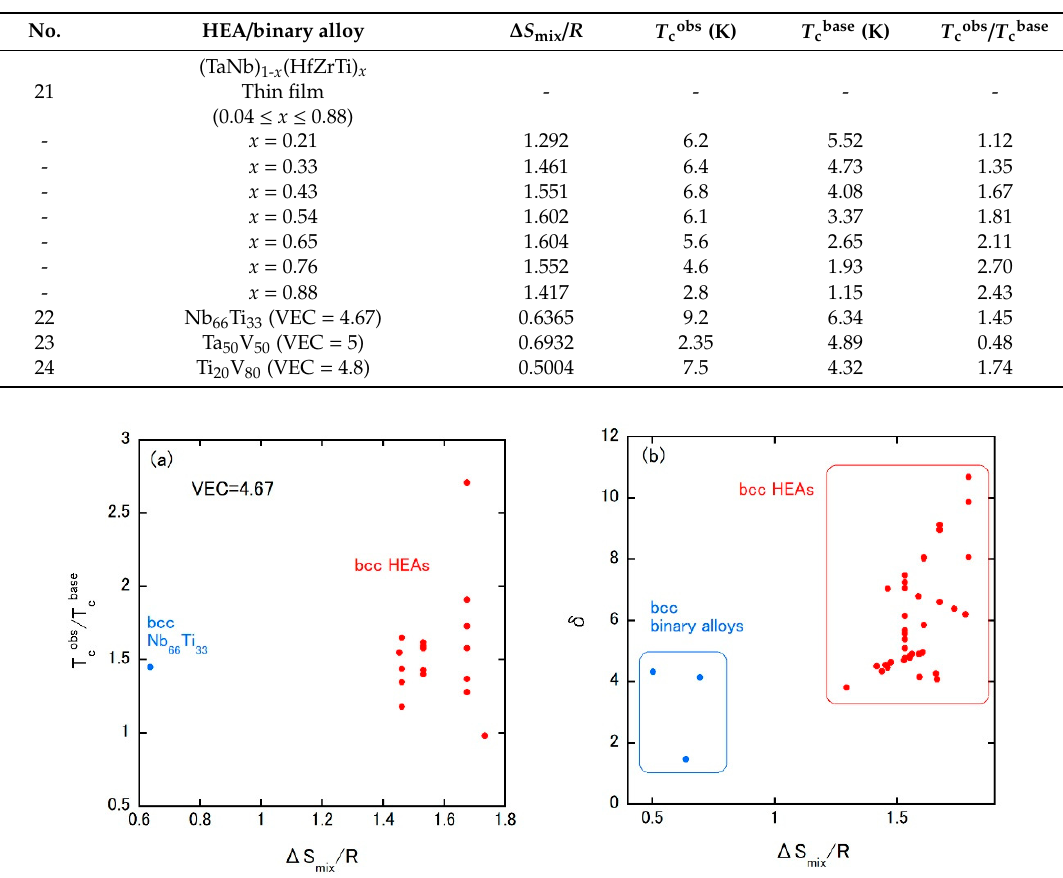
Figure 2. ∆ S mix / R dependence of ( a ) T cobs / T cbase and ( b ) δ for bcc high-entropy alloy (HEA) and binary alloy superconductors. The δ -values of bcc binary alloys are 1.47 for Nb 66 Ti 33 , 4.15 for Ta 50 V 50 , and 4.33 for Ti 20 V 80 .